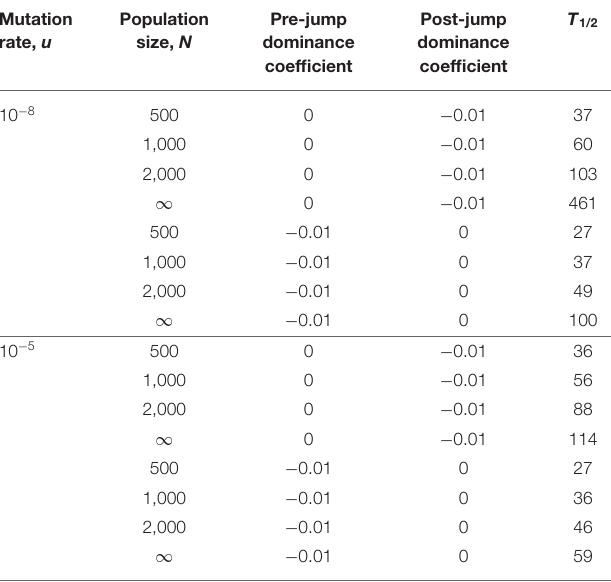
TABLE 2 | Half times to equilibrium in a finite